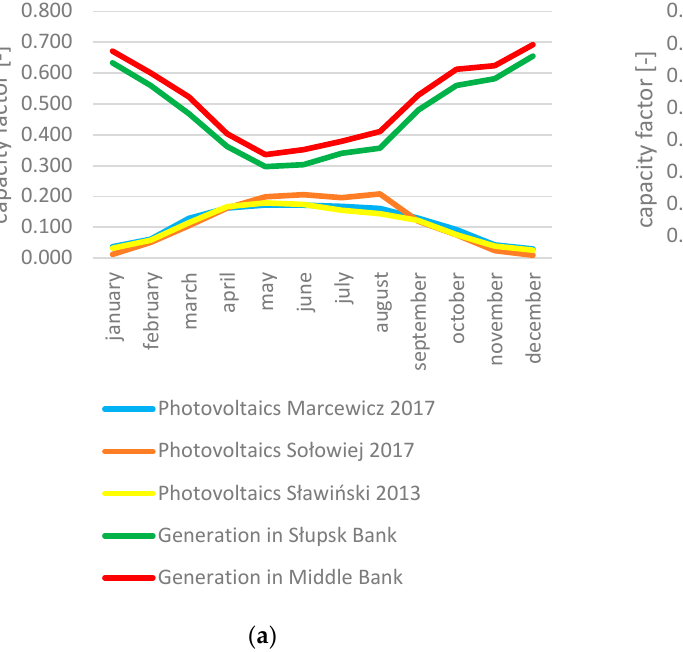
Figure 5. Capacity factor for OWF and other renewable sources: ( a ) photovoltaic sources, data from [42–44]; ( b ) onshore wind turbines, data from [45–47].